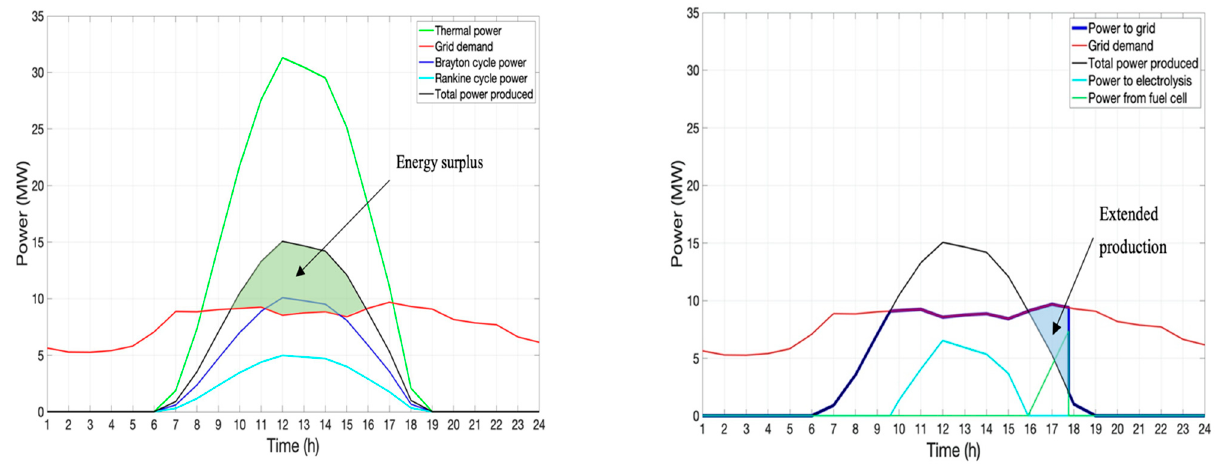
Figure 7. Hourly dispatch operation of the ISCC power plant with hydrogen system (21st of June).